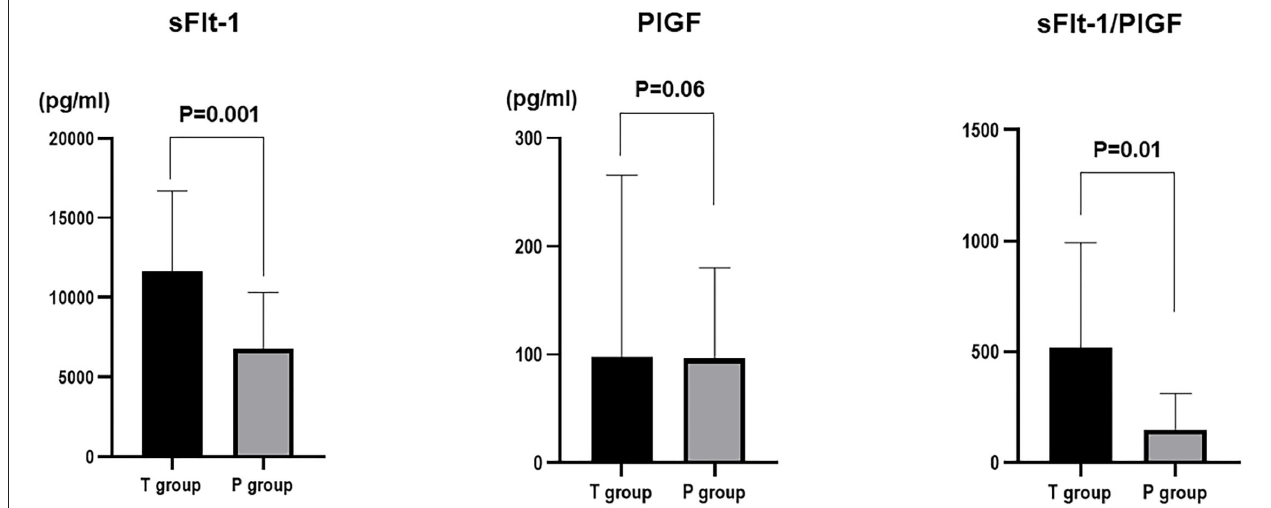
FIGURE 2 | Comparison of sFlt-1, PlGF, and sFlt-1/PlGF ratios in the group that delivered in < 1 week (T group) and the group that delivered in more than 1 week (P group).